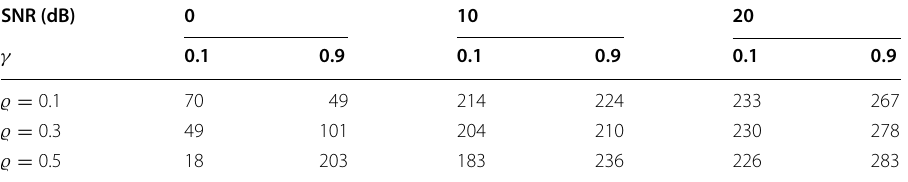
0.9 ) with different blockage probabilities ̺ =